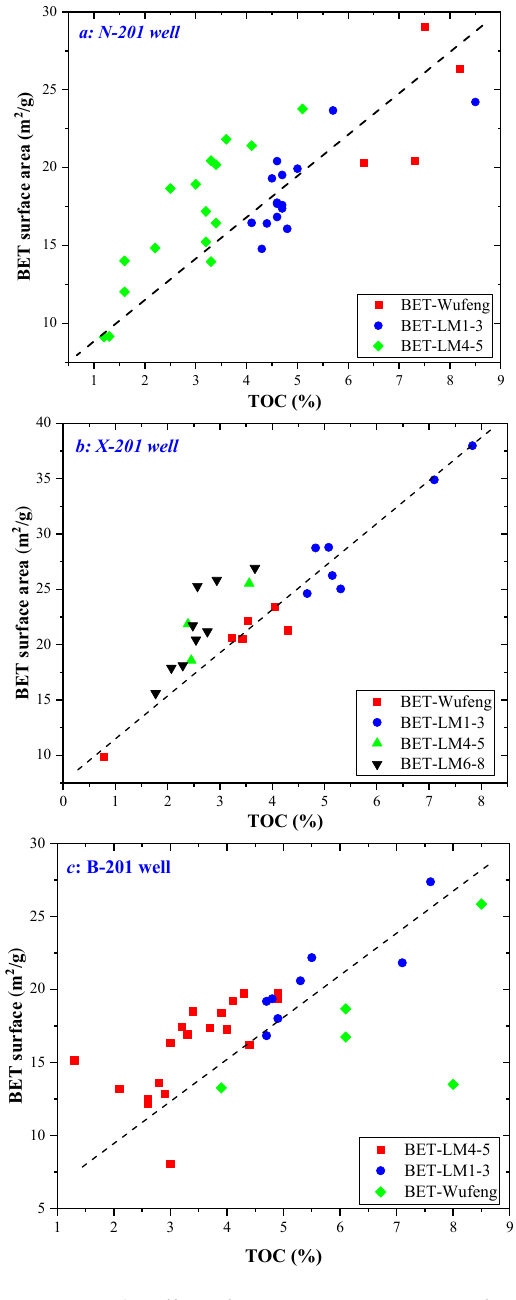
Figure 10. The effect of TOC content on BET surface area the shale samples from ( a ) the N201 well, ( b ) the X201 well, and ( c ) the B-201 well.